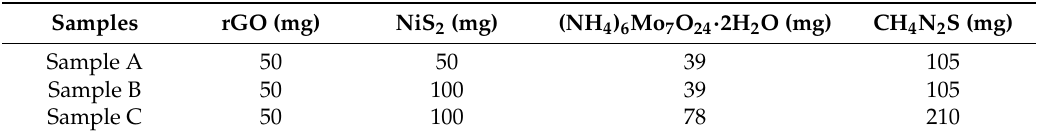
Table 1. The detailed reaction conditions for preparing NiS 2 @MoS2/reduced graphene oxide (rGO)